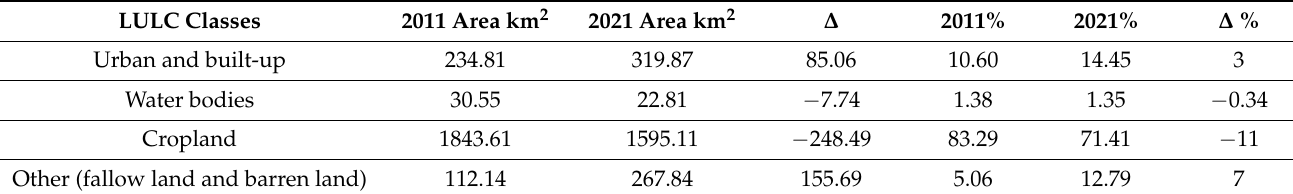
Table 3. LULC change analysis for the years 2011 and 2021.